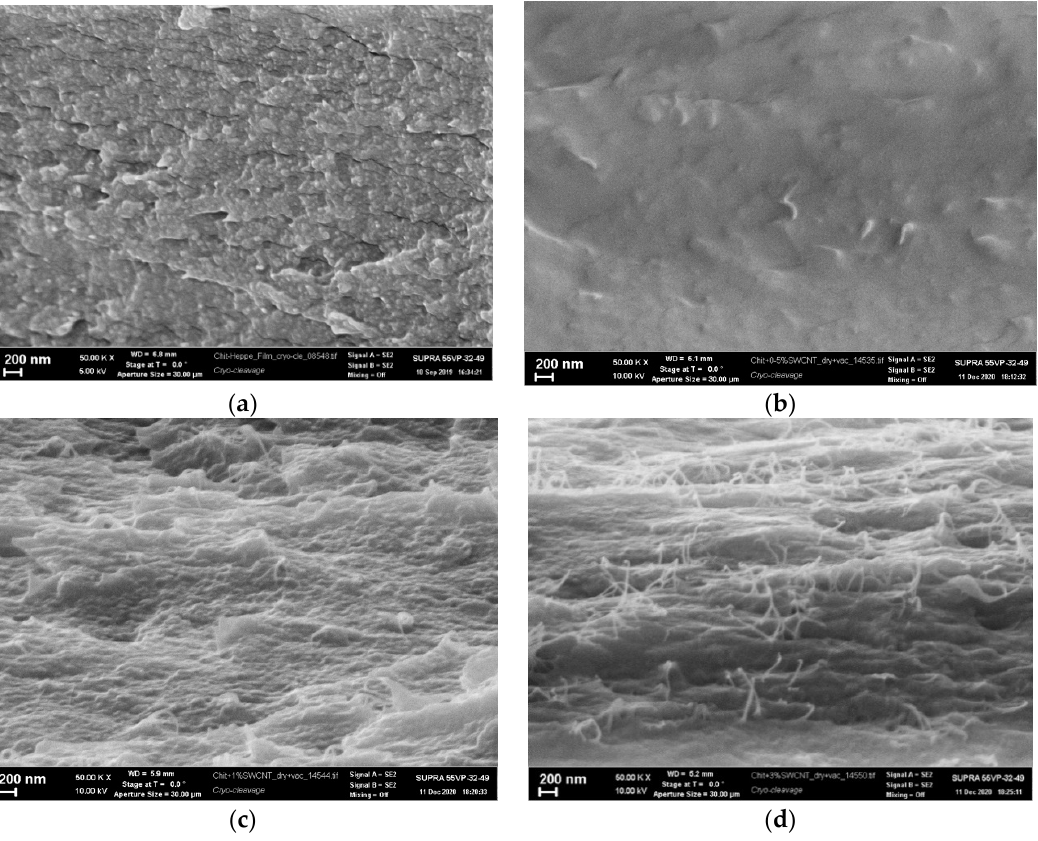
Figure 4. Microphotographs of the fracture surfaces obtained in liquid nitrogen: chitosan film ( a ), composite films containing 0.5 wt.% ( b ), 1 wt.% ( c ), and 3 wt.% of SWCNT ( d